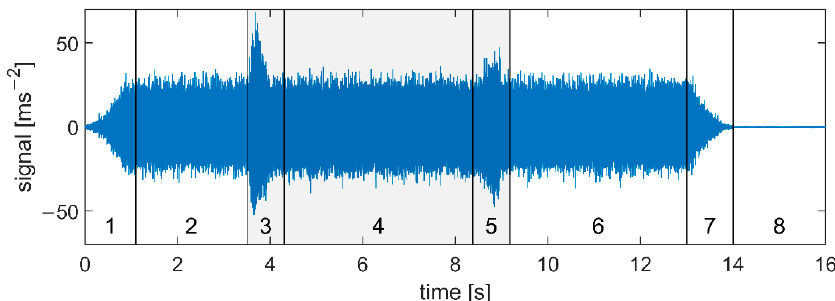
Figure 8. Detail of signal S07. Spindle switched on (1), air-cut (2), start of cut (3), full cut (4), end of cut (5), air-cut (6), spindle switched off (7), noise (8). The grey area shows where the cutting tool is in the cut.